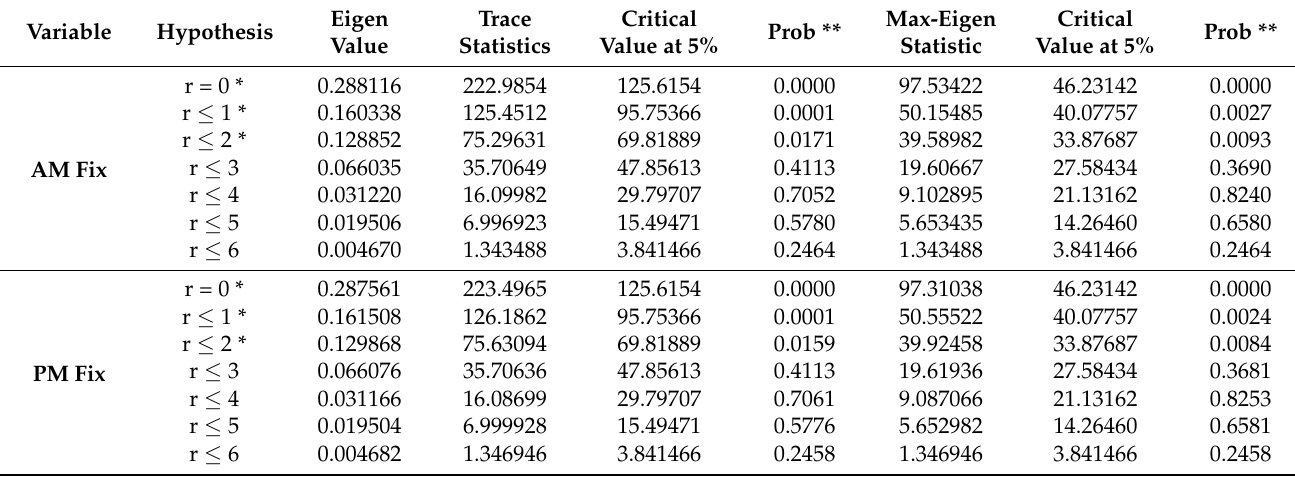
Table 4. Results of long-run relationship between the gold prices and gold